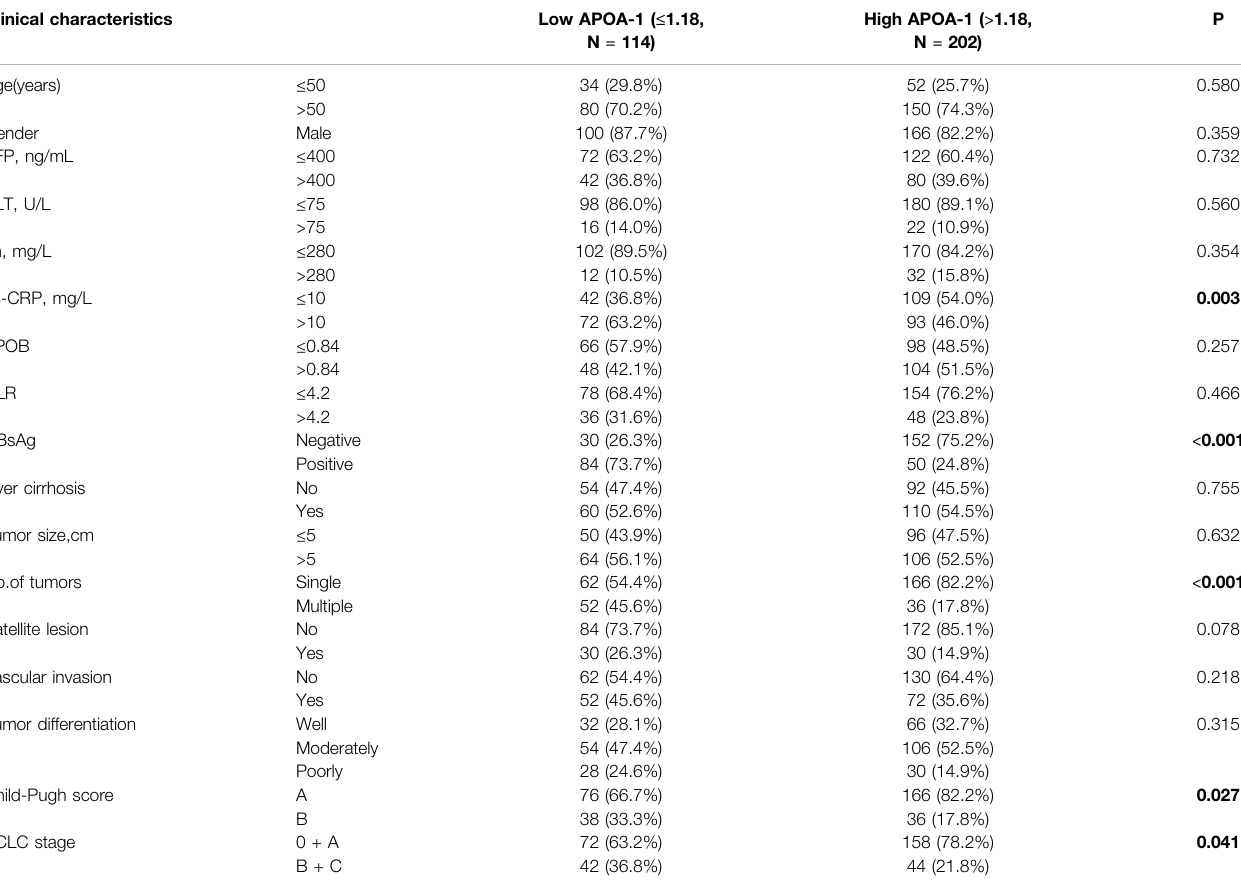
TABLE 2 | Correlation between serum APOA-1 levels and clinicopathologic characteristics of 316 patients with HCC. Clinical